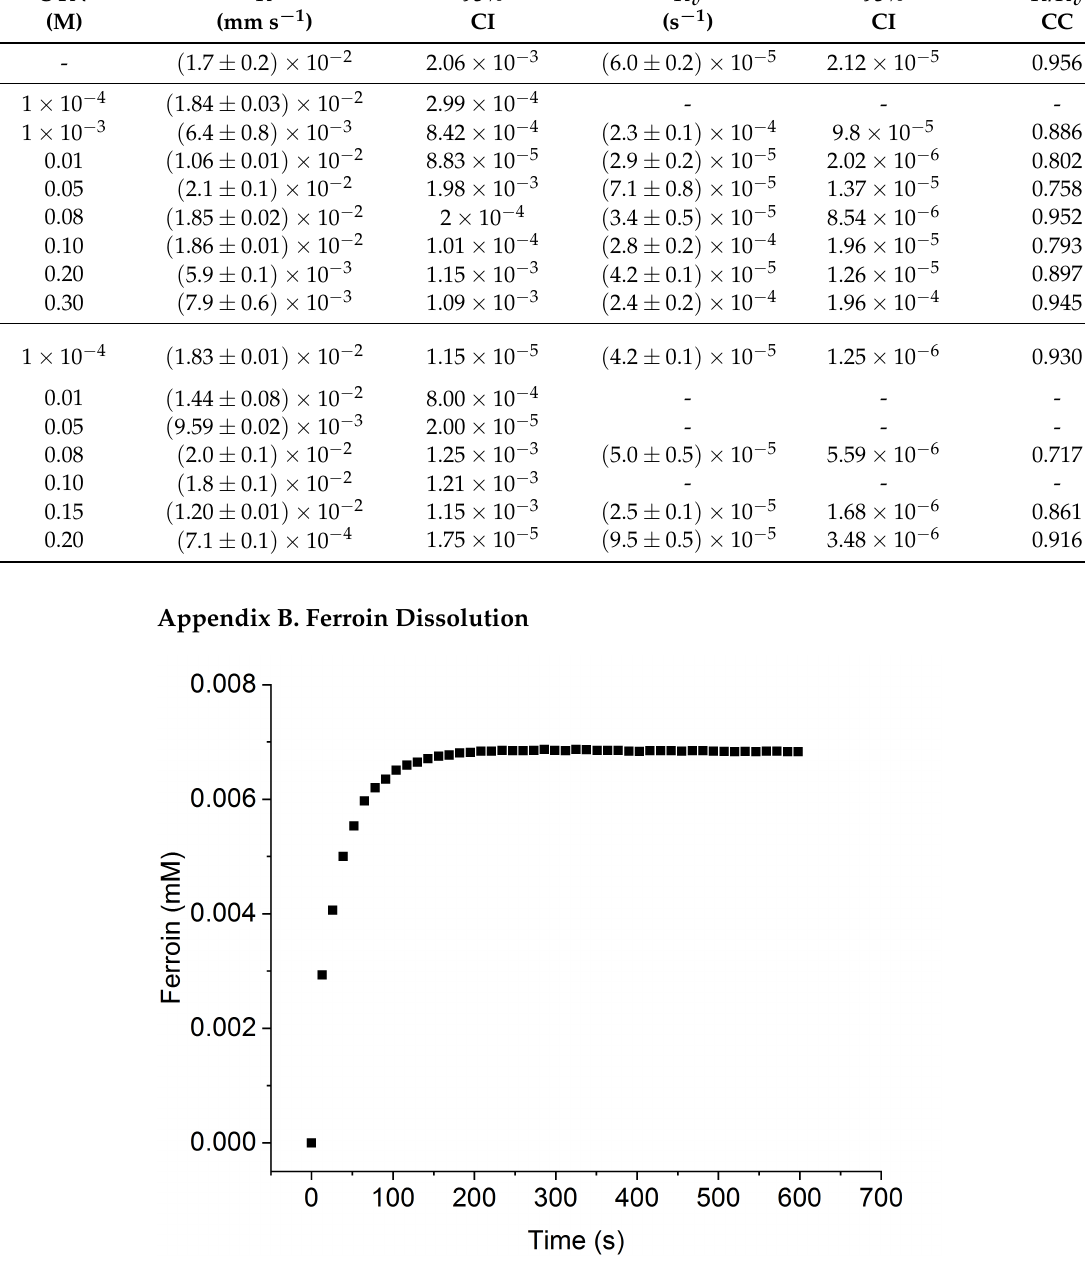
Figure A1. Dissolution of 5 µ L of ferroin 25 mM in 18 mL of water at 2010